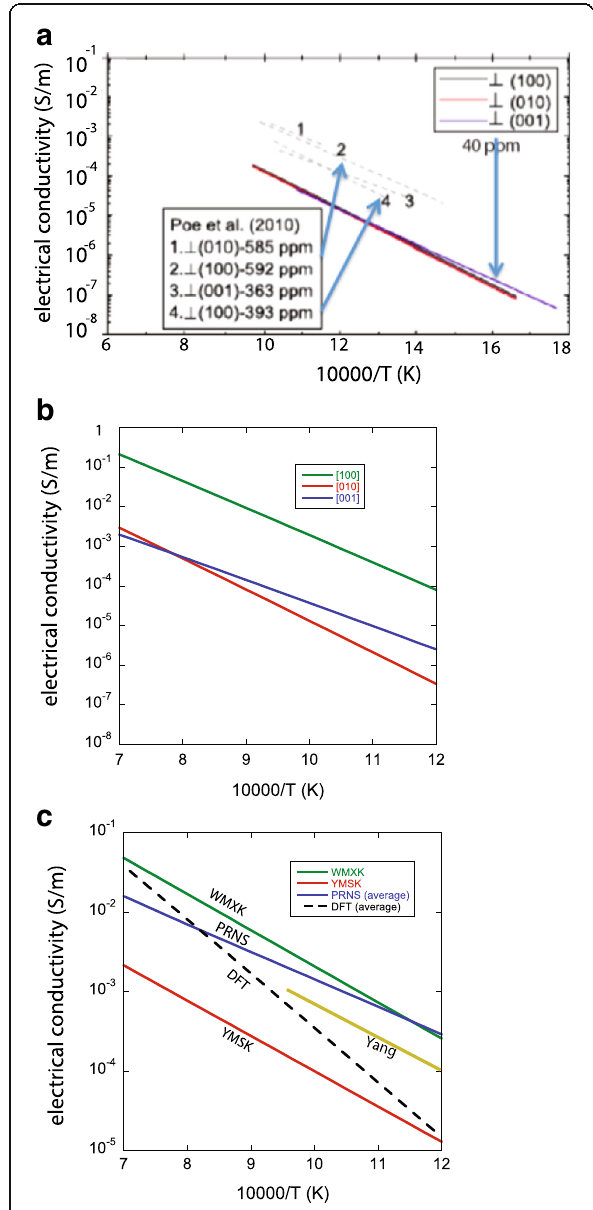
Fig. 7 A few examples showing the diffusion-electrical conductivity discrepancy. a Electrical conductivity of olivine single crystals measured at low temperatures (Poe et al. 2010; Yang 2012) showing small anisotropy. b Electrical conductivity of olivine calculated from diffusion coefficients showing high anisotropy and large activation enthalpy. c A comparison of electrical conductivity. WMXK: Wang et al. (2006). YMSK: Yoshino et al. (2009). PRNS: Poe et al. (2010). Yang: Yang (2012). DFT: Du Frane and Tyburczy